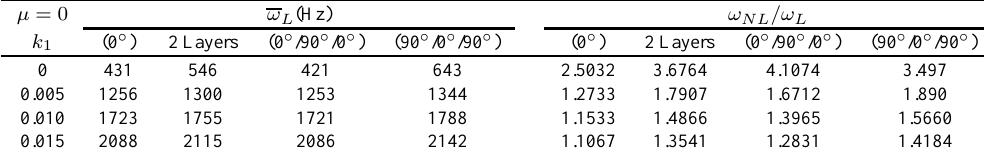
Table 10 Variation of the natural and relative frequencies with respect to non-dimensional foundation modulus k 1 , number and ordering of layers for µ = 0 ( m = 1 , n = 7 , h 1 = 2 . 54 × 10 − 4 (m), A p /h 1 = 3